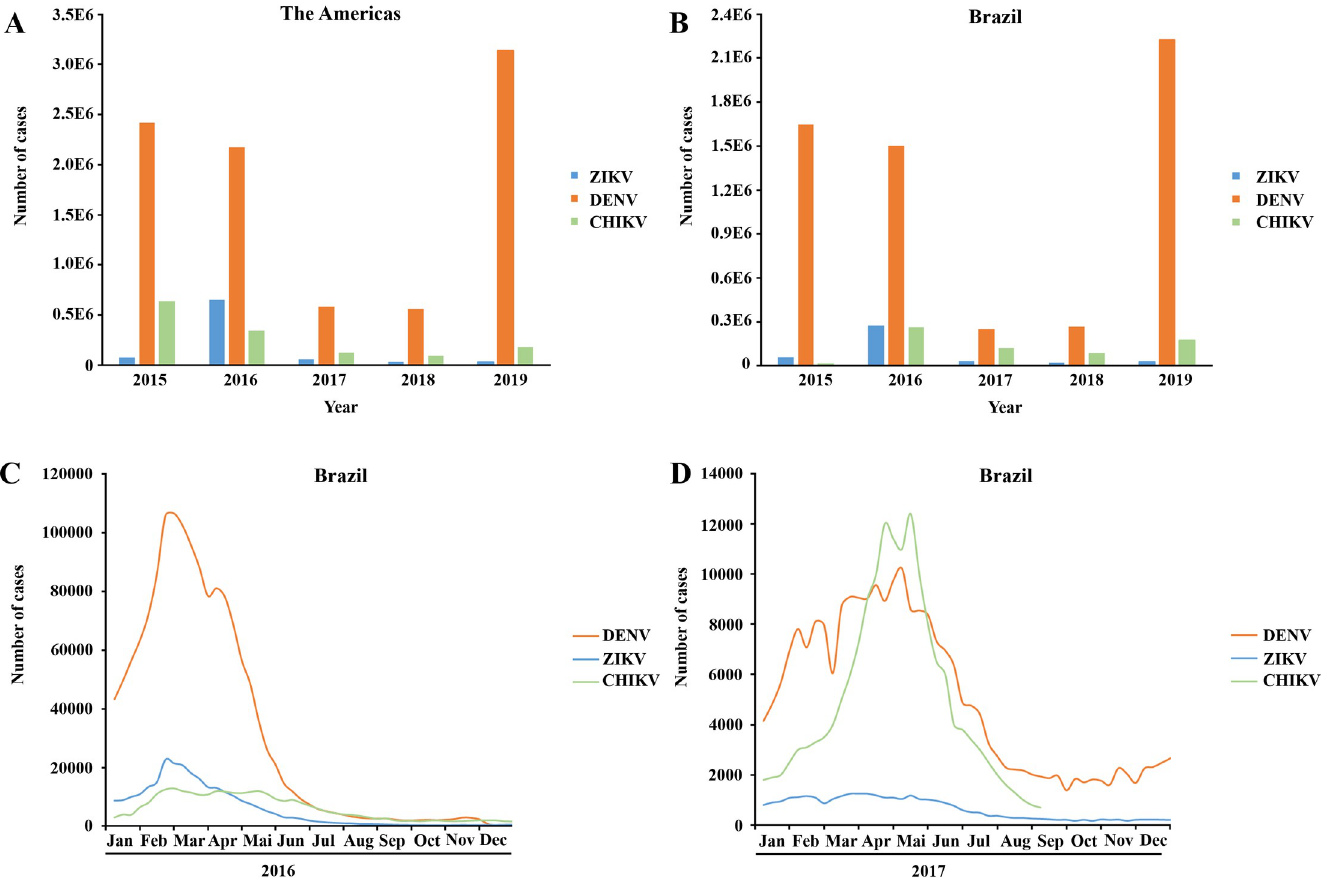
Fig 1. Reported cumulative cases of CHIKV, DENV and ZIKV from 2015 to 2019 in the Americas and Brazil. Based on PAHO and WHO (PAHO/WHO, 2020) [15]. ZIKV infections colored in blue, DENV in orange and CHIKV in green. A: Confirmed ZIKV, DENV and CHIKV cases in the Americas from 2015 to 2019. B: Confirmed ZIKV, DENV and CHIKV cases in Brazil from 2015 to 2019. C: Confirmed ZIKV, DENV and CHIKV cases in Brazil 2016. D: Confirmed ZIKV, DENV and CHIKV cases in Brazil